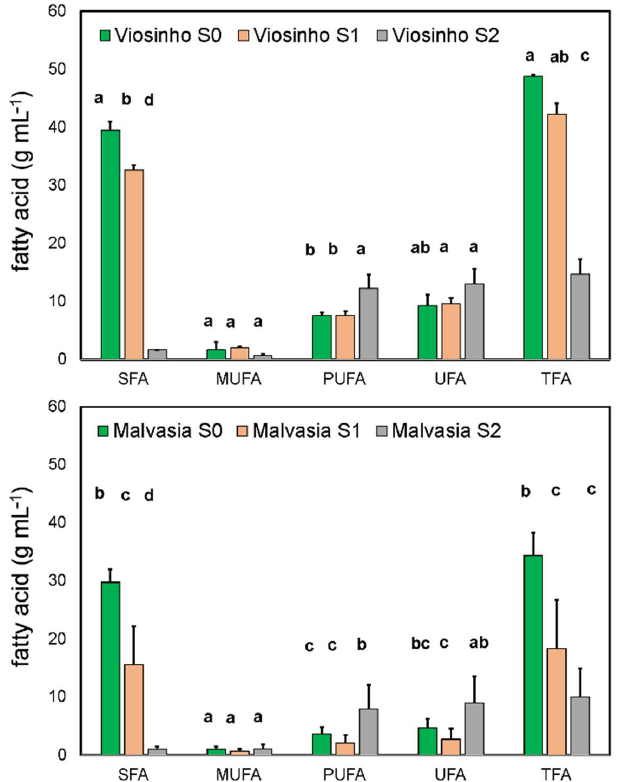
Figure 1. Contents of fatty acids in berries of Viosinho and Malvasia-fina grapevine varieties healthy (S0; severity level 0), moderately (S1; severity level 1), and severely (S2; severity level 2) affected by esca complex disease. Error bars represent standard deviation over three replications. Comparing the two varieties, value bars with different letters for each parameter are different (Turkey’s test, p ≤ 0.05). SFA = saturated fatty acids, MUFA = monounsaturated fatty acids, PUFA = polyunsaturated fatty acids, UFA = unsaturated fatty acids, TFA = total fatty